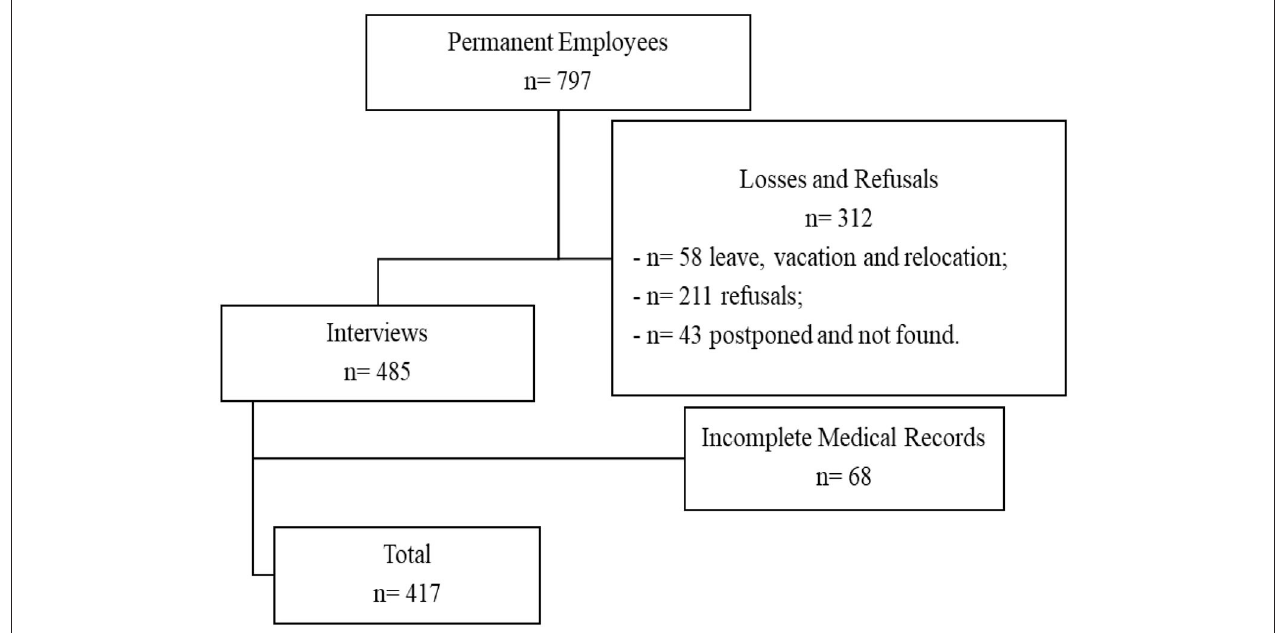
FIGURE 1 | Diagram of representation of the population of